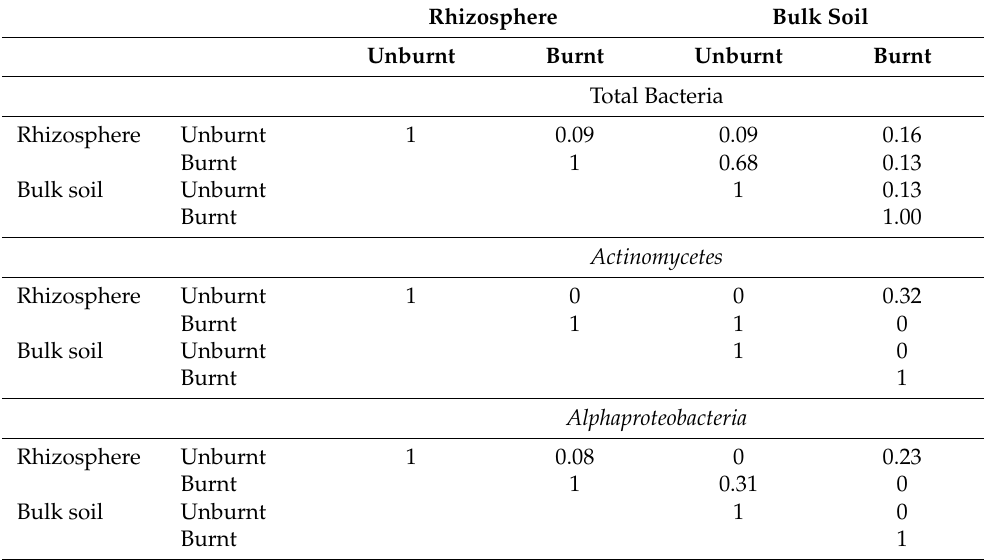
Table 1. Bray–Curtis index of similarity applied in the overall bacterial community and the commu- nity of Actinomycetes and Alphaproteobacteria collected in the different